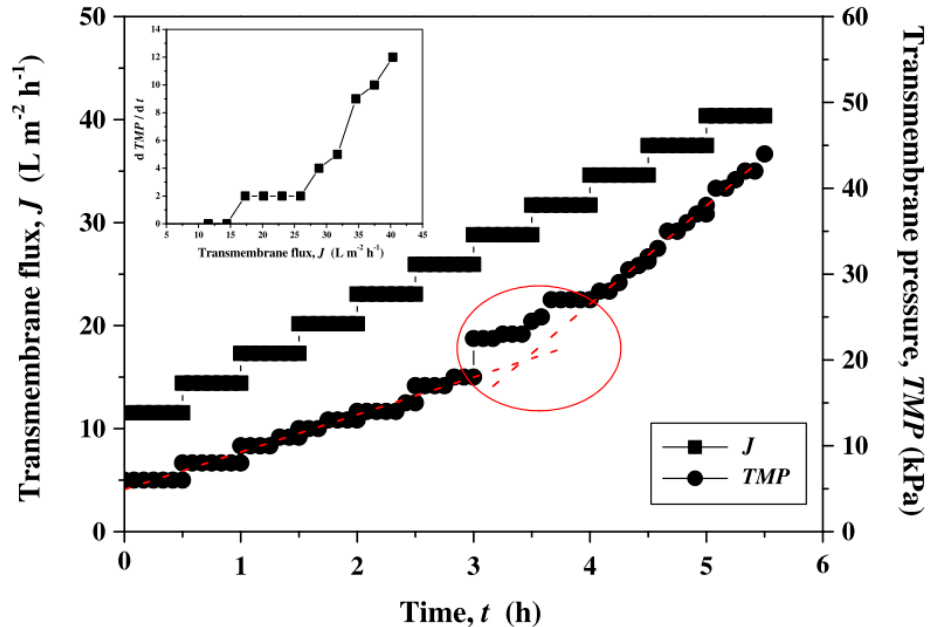
Figure 2. The transmembrane flux (J) and pressure (TMP) as a function of time (t) for seawater filtration experiments with increasing flux steps. Reprinted with permission from Ref. [26]. Copyright 2011 Elsevier.